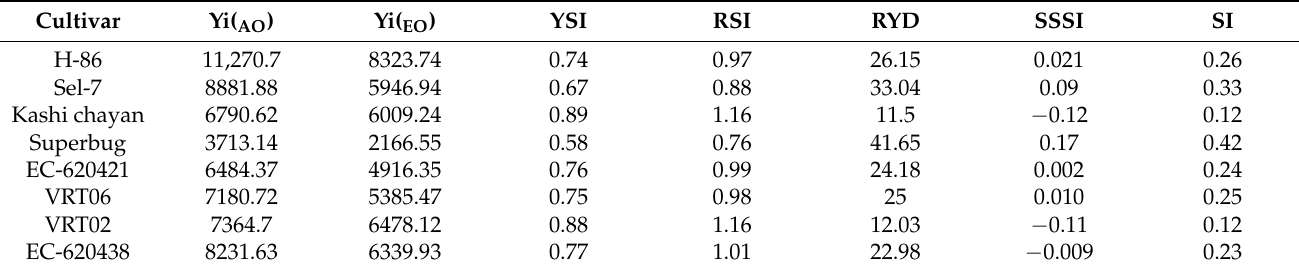
Table 1. Yield Indices calculated on the basis of fruit yield where (Yi) AO = Yield (g/m 2 ) under ambient O 3 condition, (Yi) EO = Yield (g/m 2 ) under elevated O 3 condition, YSI = yield stability index, RSI = Relative stress index, RYD = Relative yield decrease, SSSI = Schneider’s Stress Severity Index, SI = Susceptibility